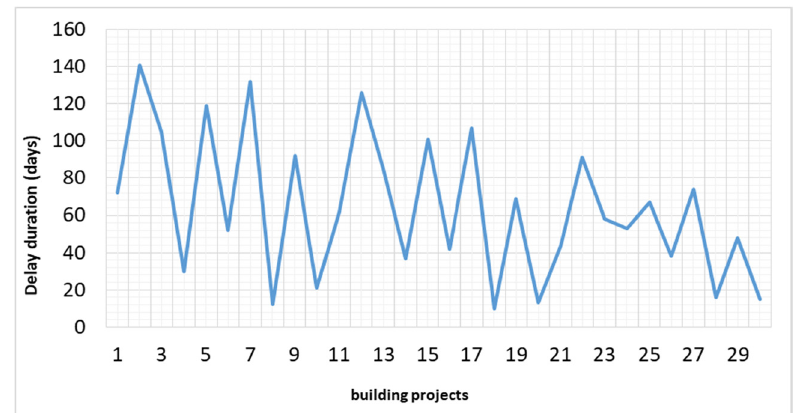
Figure 3: Line chart of the total delay due to fi ve factors in 30